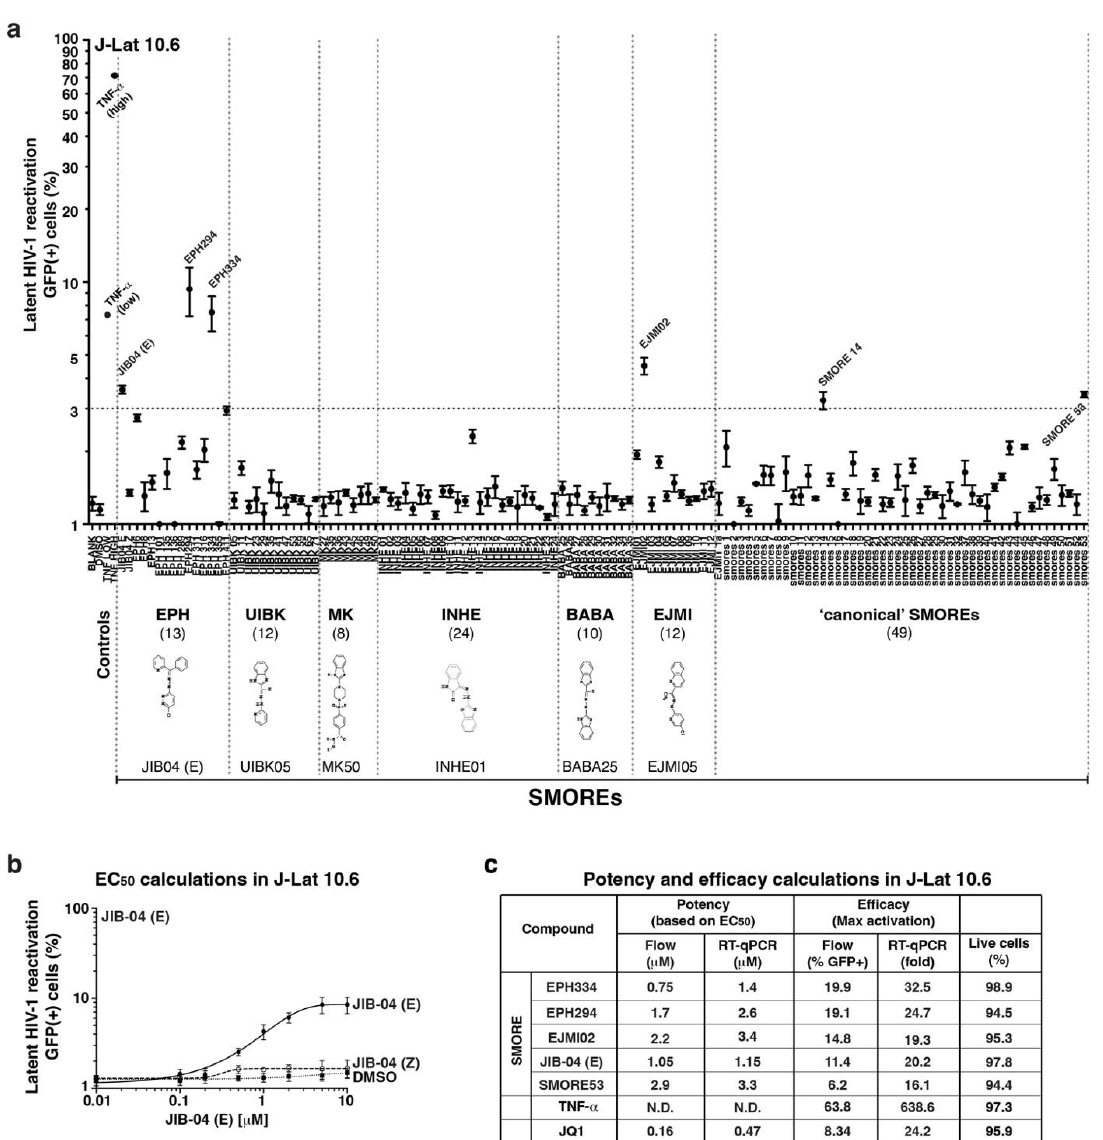
Figure 1. Small compound targeted screen data for latent HIV-1 reactivation, potency, and efficacy studies. ( a ) J-Lat 10.6 cells were treated as indicated in the text and latent HIV-1 reactivation measured by flow cytometry to assess levels of GFP expression. The number of compounds per group is indicated in brackets and representative chemical structures of one compound per group are shown. The dashed line differentiates compounds that activate more than 3-fold over control samples (DMSO) compared to those that do not activate or activate less than 3-fold. TNF- α high (10 ng/mL) or low (1 ng/mL) concentrations were used as positive controls to gauge the dynamic range of the response. The percentage of GFP-positive cells from three independent runs is indicated (mean ± SEM; n = 3). ( b ) Example of EC 50 calculations in J-Lat 10.6 cells by flow cytometry. Plots were derived using a nonlinear regression equation and an asymmetric sigmoidal curve fit to the raw values. GFP background was about 1.5%. The number of GFP positive cells from three independent runs is indicated (mean ± SEM; n = 3). ( c ) Potency and efficacy values. J-Lat 10.6 cells were treated with increasing drug concentrations (0.15, 0.3, 0.6, 1.15, 2.5, 5, and 10 µ M) and potency and efficacy calculated by flow cytometry and RT-qPCR. Quantitation of percentage of GFP-positive cells by flow cytometry from max dose. Quantitation of HIV-1 RNA levels with VQA amplicon normalized to RPL19 by RT-qPCR at max dose. The SEM from three independent experiments is indicated. N.D. denotes not